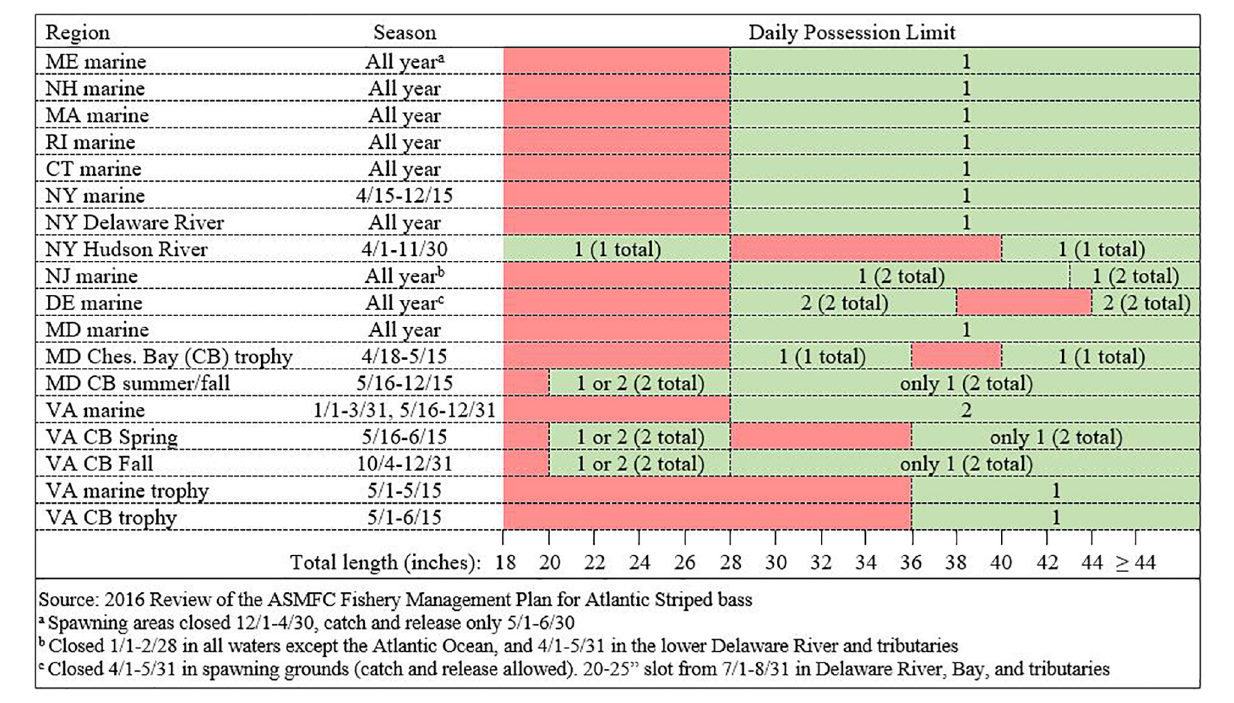
FIGURE 2 | 2015 recreational striped bass